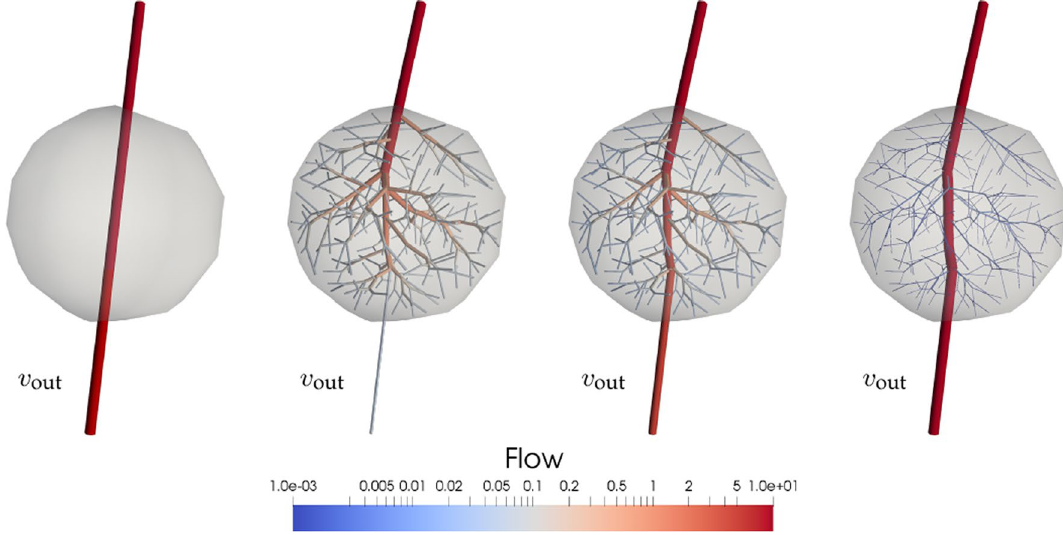
Figure 5. Flow delivery in the presence of an outlet vessel v out with a prescribed outflow: (from left to right) tree initialisation, flow to be distributed is Q ; v out flow is unconstrained, i.e., outlet carries the same flow than terminals inside the domain; v out flow is constrained to 0.5 Q ; and v out flow is constrained to 0.99 Q . Images generated with ParaView version 5.4 available at https ://www.parav